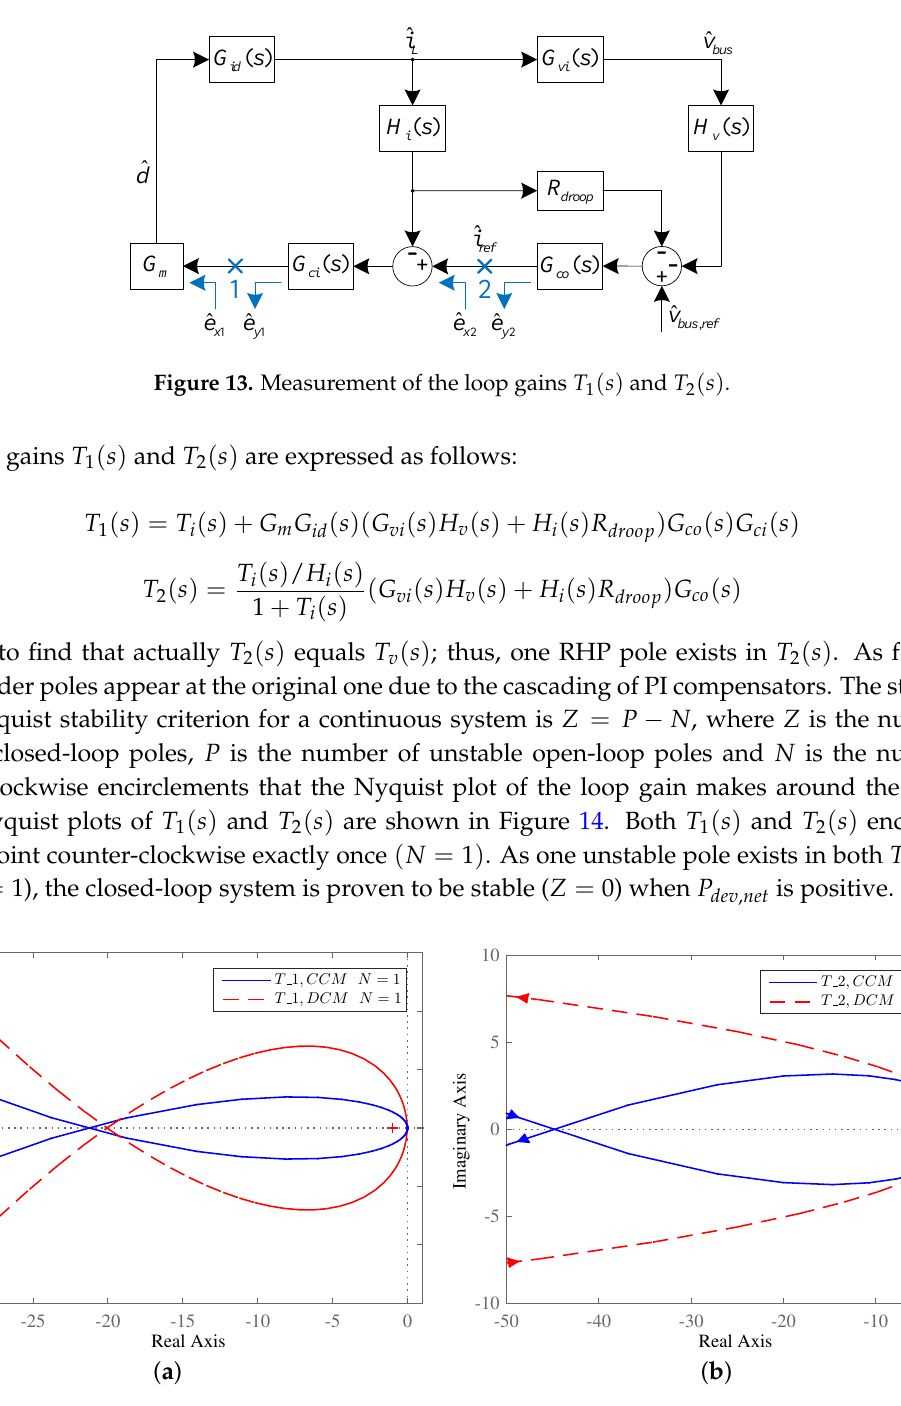
Figure 14. Nyquist plots of ( a ) T 1 ( s ) and ( b ) T 2 ( s ) when P dev , net >